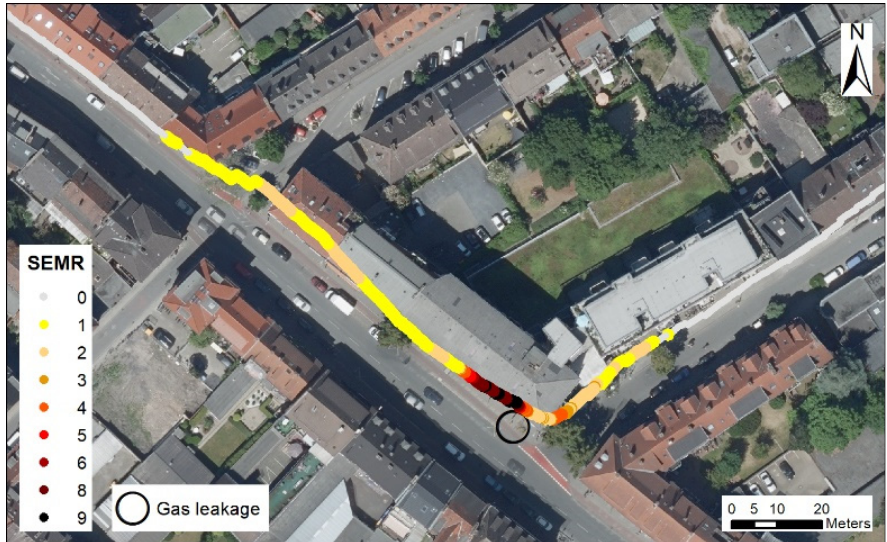
Figure 4. Location J07_10 with indication of SEMR along the route and localization of the leakage at the gas network; Note: depicted route deviates by a few meters to the north from the actually driven route; Map source: DOP, © Geobasis NRW 2017, DL-DE->Zero-2.0, (http://www.govdata.de/dl-de/zero-2-0, accessed on 1 November 2021). URL: https://www.bezreg-koeln.nrw.de/brk_internet/geobasis/webdienste/geodatendienste/index.html (accessed on 1 November 2021).